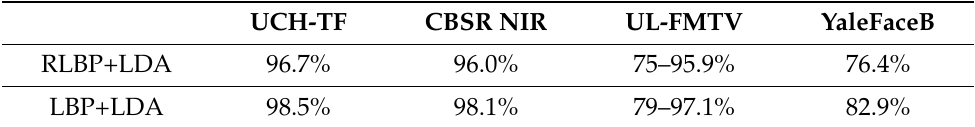
Table 4. Accuracy of our method with RLBP and LBP using different databases.